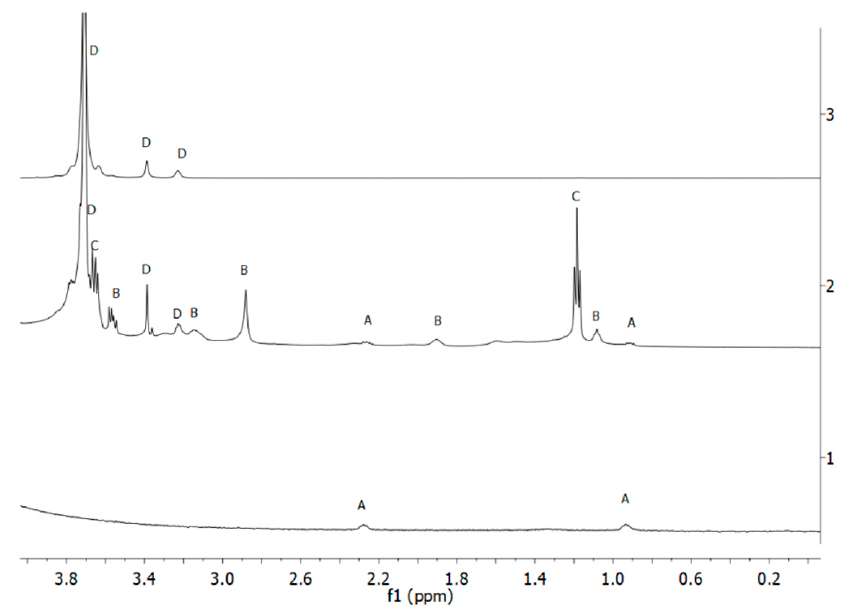
Figure 1. 1D NMR spectra recorded with the noesypr1d sequence on water suspensions prepared with 10% D 2 O of the bare NP, bearing carboxylate functions on their surface (bottom spectrum), of the NP grafted with PEG (central spectrum), and of free PEG (top spectrum). The letters are used to assign the different peaks to the different molecules: A corresponds to CETS, B corresponds to EDCI, C corresponds to ethanol and D corresponds to PEG.